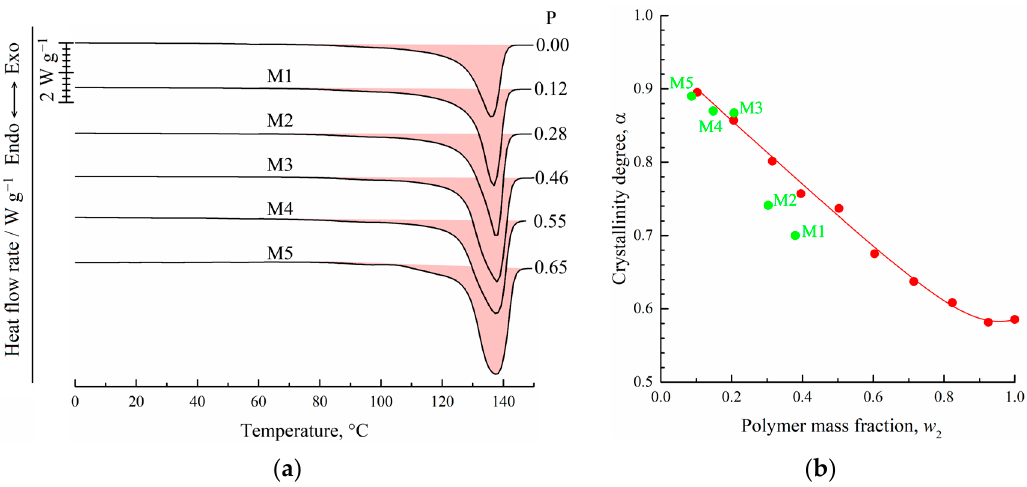
Figure 5. DSC-thermograms obtained during the first heating of the film and membrane samples M1–M5 ( a ). The porosity of the samples (P) is shown to the right of the curves. Dependence of the UHMWPE crystallinity degree on polymer concentration in its initial mixture with o-xylene ( b ). Red points were plotted according to DSC data for mixtures during their second heating. Green points correspond to values of the crystallinity degree of the membrane samples M1–M5.